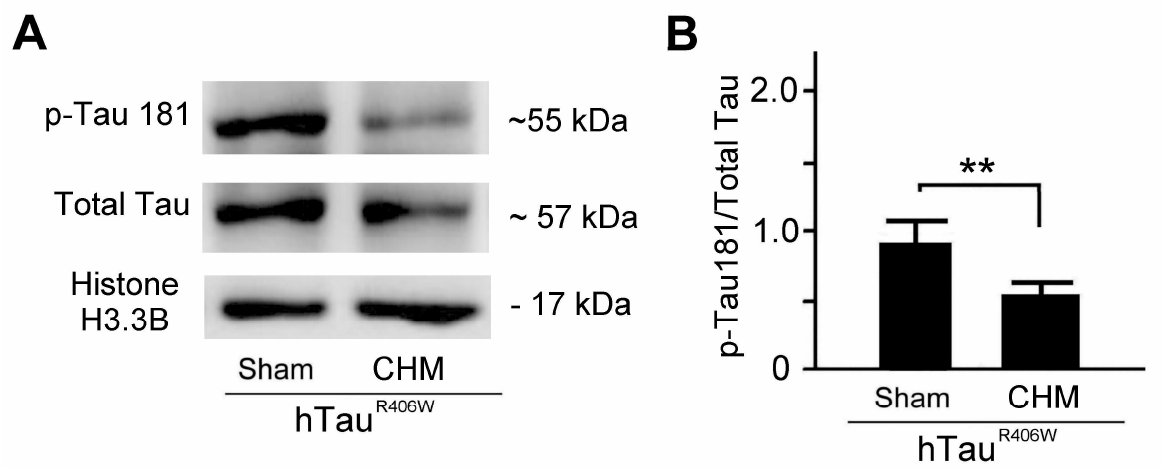
Figure 5. Chinese herbal medicine treatment showed favorable therapeutic effects for tauopathy alleviation by Western blotting: ( A ) Example of Western blotting analysis of p-Tau 181 and total Tau expressions in hTau R406W flies and their WT counterparts under sham and Chinese herbal medicine (CHM) treatments. ( B ) Quantified comparison of the ratio of p-Tau 181 to total Tau expressions among hTau R406W flies under sham and CHM treatment (three replicate experiments for each group). Values are mean ± SEM (** p < 0.01, Kruskal–Wallis non-parametric test for multiple comparisons and followed by the Mann–Whitney non-parametric test for comparisons of two independent samples). kDa, kilodaltons.